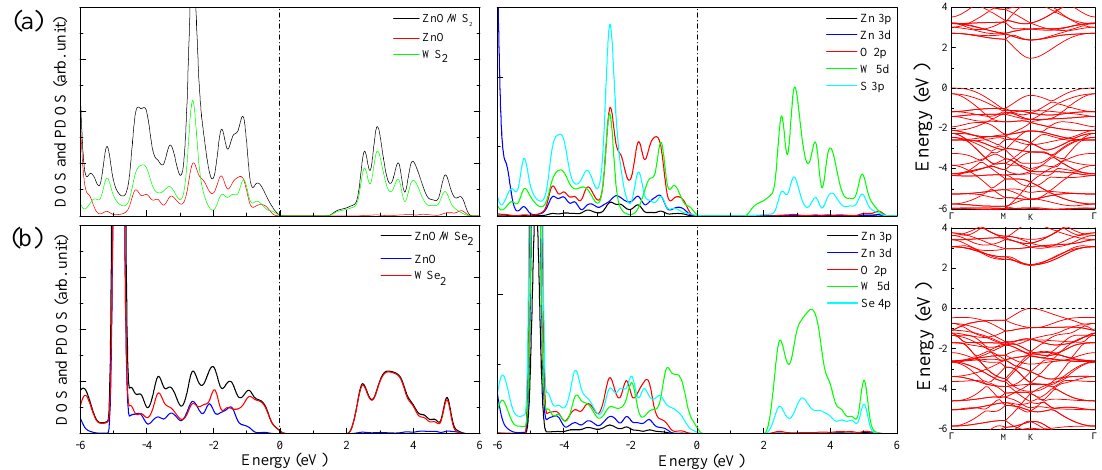
Figure 6. DOS, PDOS, and band structures of ( a ) ZnO/WS 2 and ( b ) ZnO/WSe 2 .